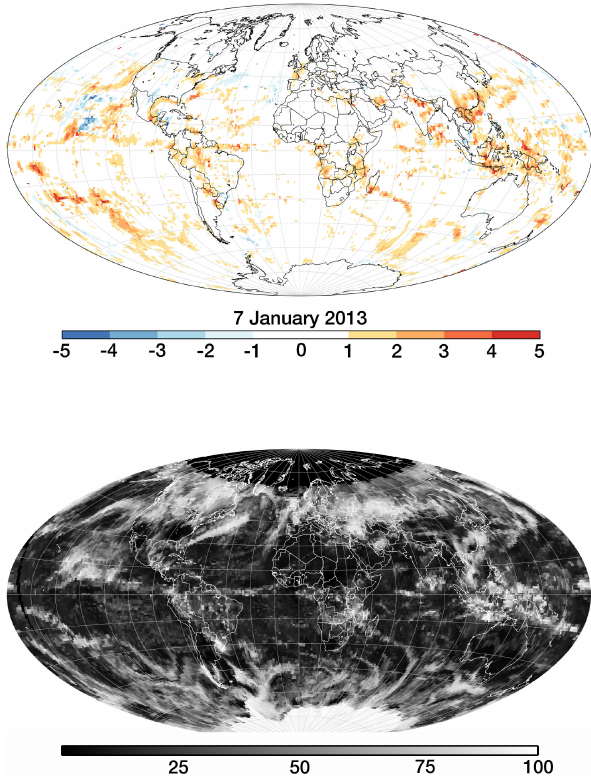
Figure 7. Total ozone differences (in %) due to the use of retrieved cloud OCPs instead of the OMI cloud OCP climatology (top) and OMPS-derived reflectivity (in %) at 331nm for 7 January 2013 (bottom).